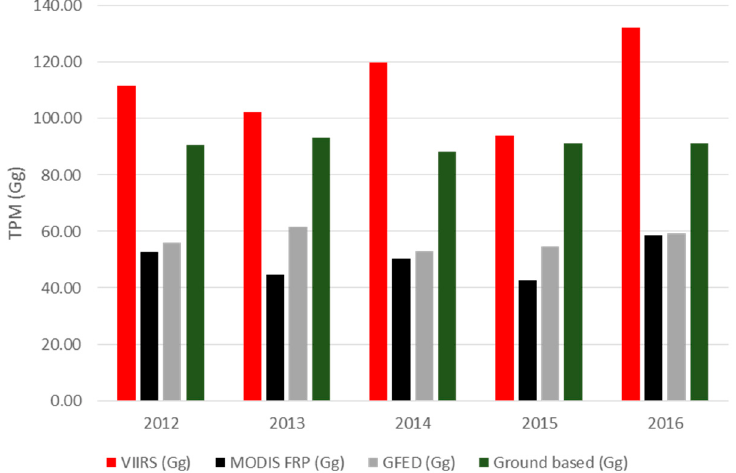
Figure 10. TPM emissions (2003–2016) derived from model fitting of VIIRS and MODIS data.